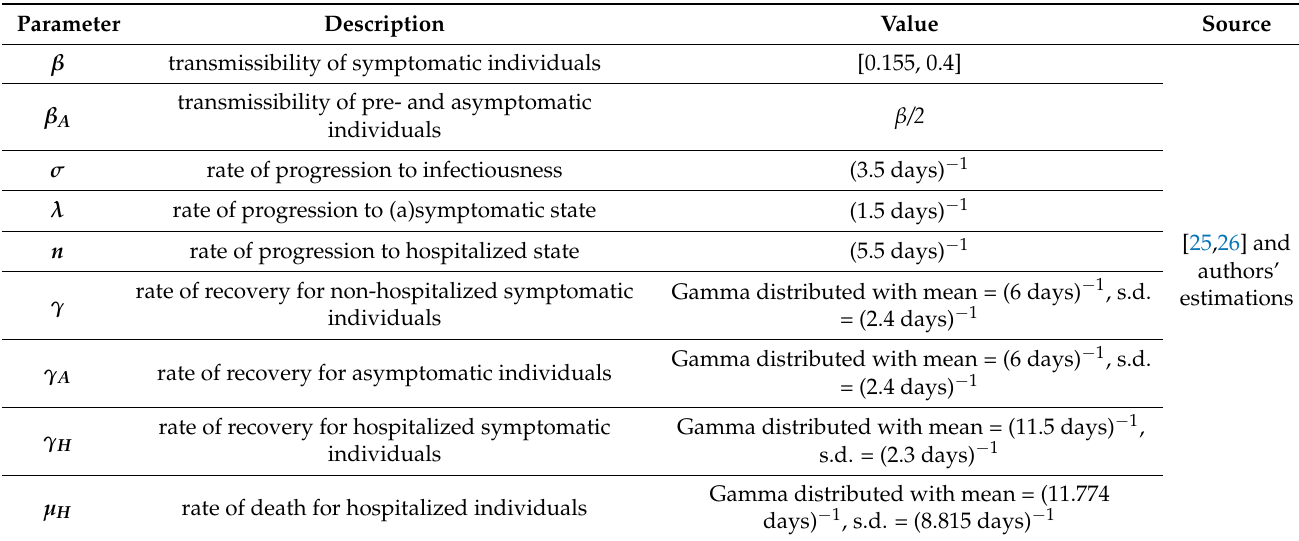
Table 2. Non age-dependent parameters’ values of the Phase 1 SEIR and Phase-2 SVEIR models used to assess COVID-19 transmission dynamics in